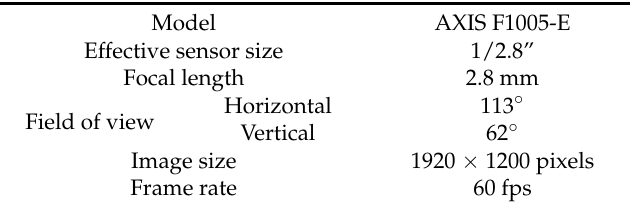
Table 1. Specifications of the network video camera.